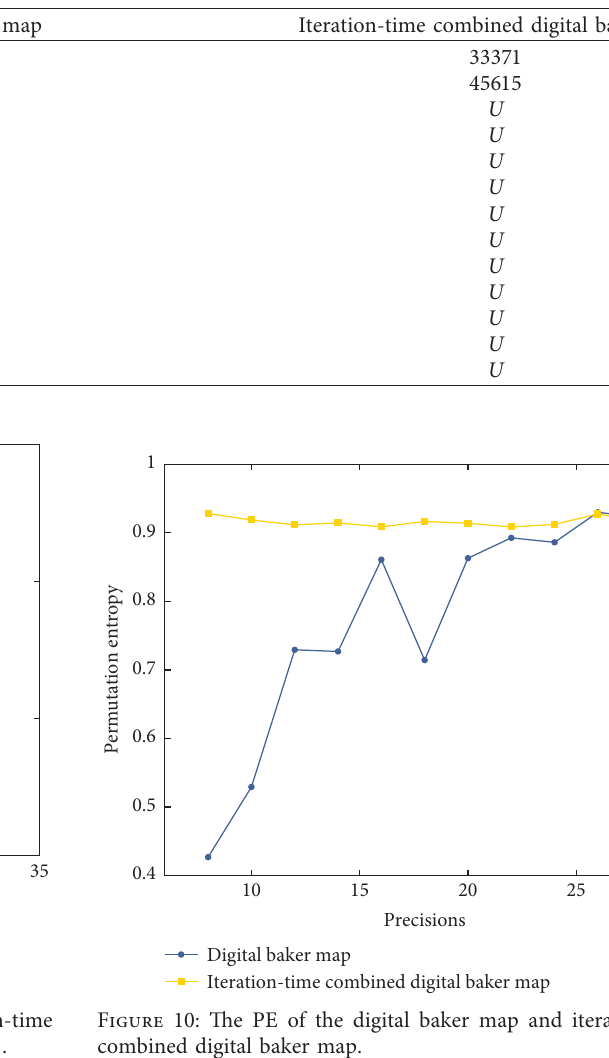
Figure 8: The Auto-correlation function of two maps. (a) Digital baker map; (b) iteration-time combined digital baker Table 2: Period analysis of two maps ( U denotes undetected).